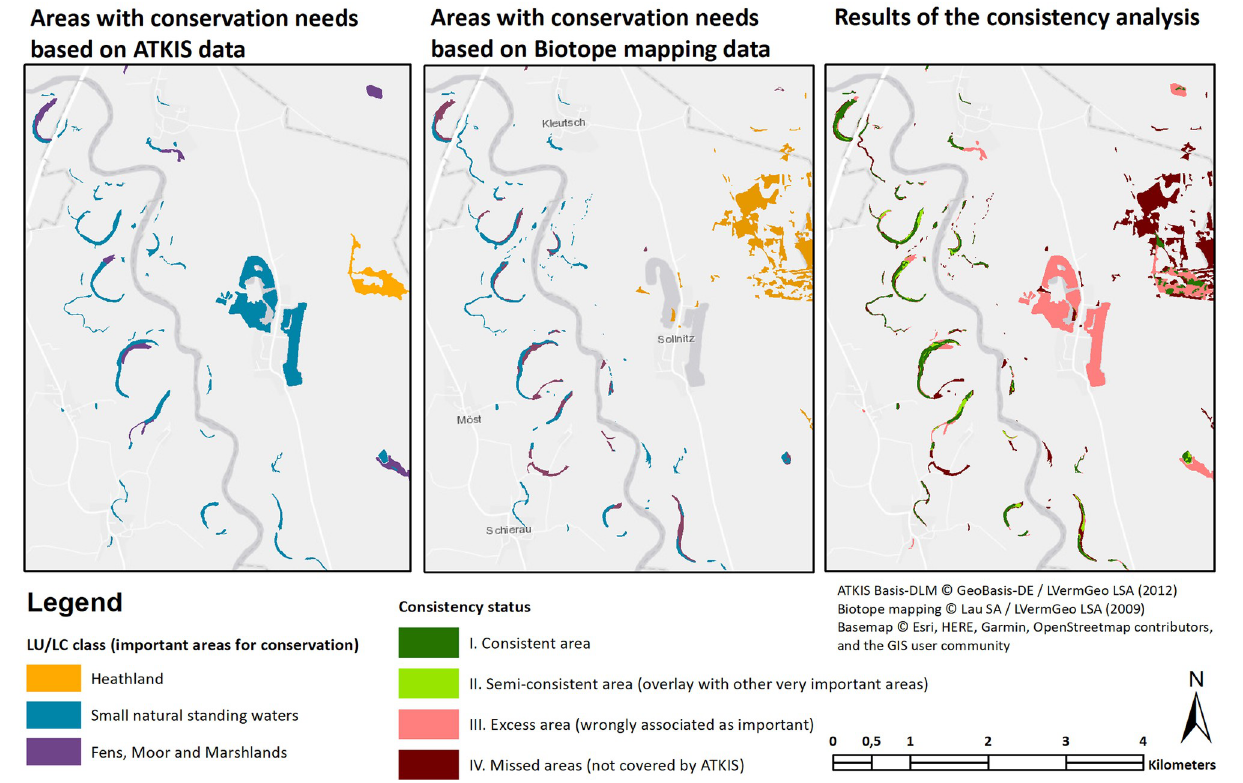
Fig 2. Spatial representation of selected results of the case study ‘state-wide habitat conservation siting’.